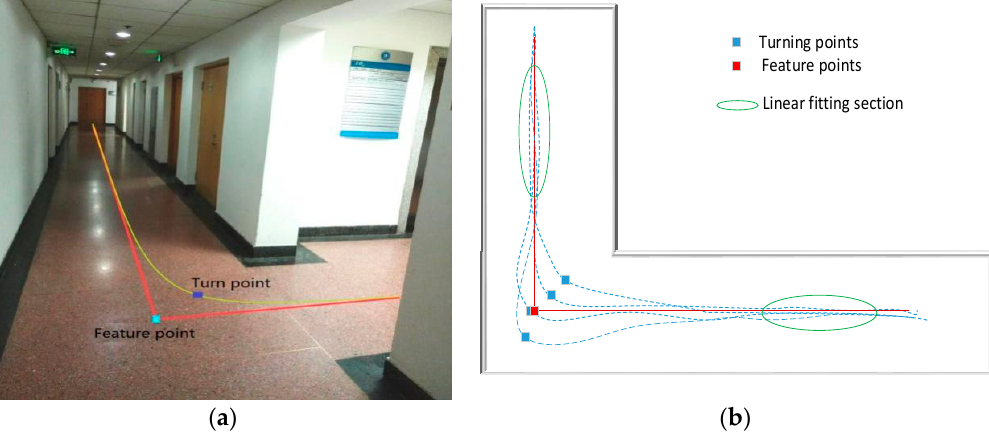
Figure 2. ( a ) Part of the experiment site and ( b ) the schematic diagram of the fitting of the straight walking